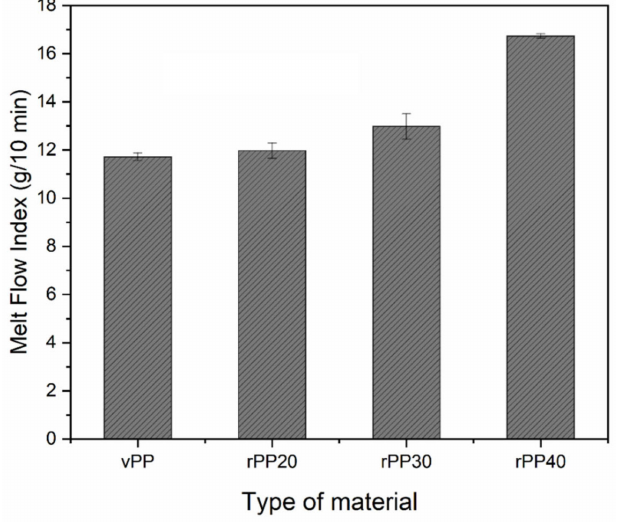
Figure 2. Melt flow index of all prepared